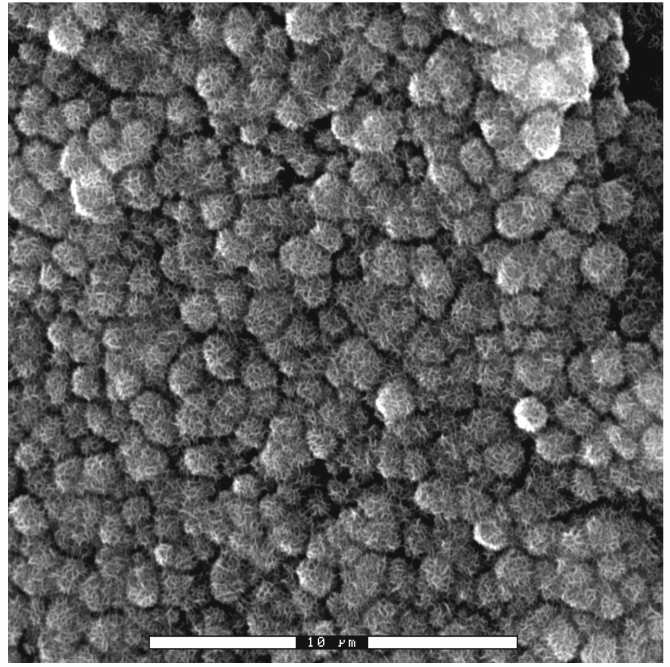
Figure 7. Titanium dental implant surface completely covered with apatite.